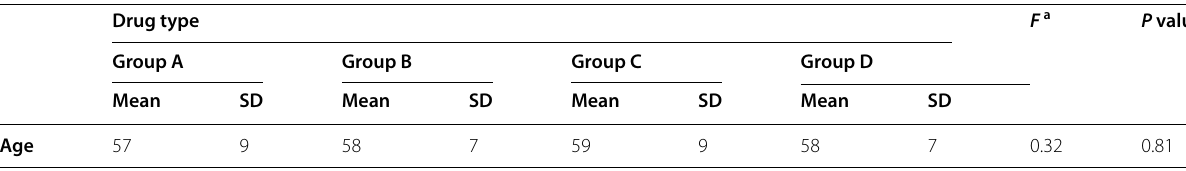
a One-way ANOVA